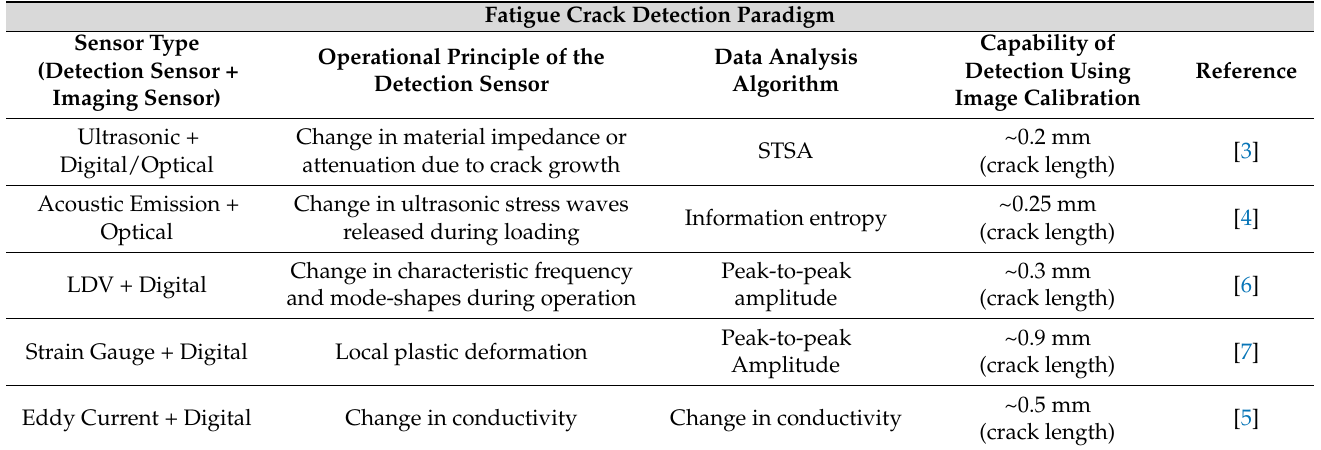
Table 1. A comparison of the crack detection capabilities for various imaging and sensing techniques. Fatigue Crack Detection